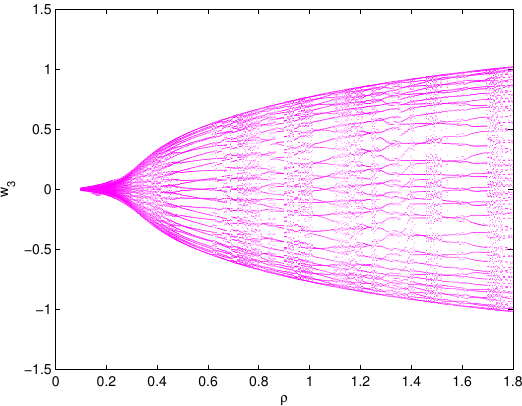
Figure 10. Bifurcation figure of system (96): ρ versus w 3 . The bifurcation value ρ (cid:63) ≈